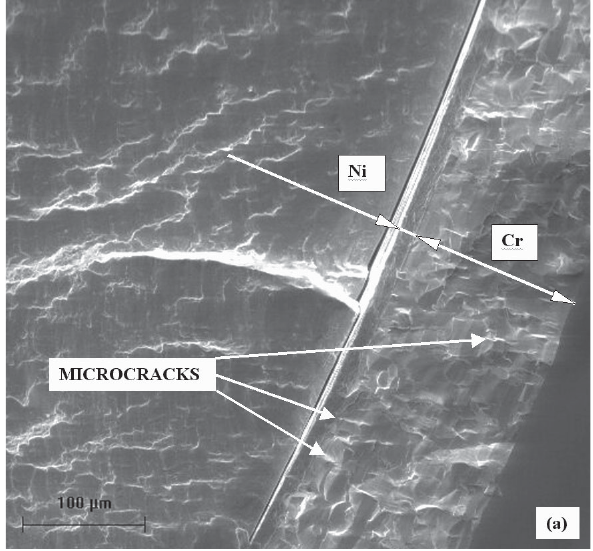
Figure 5a. Fracture surface of accelerated hard chromium (145 µ m) on electroless nickel (15 µ m) plating, unshot peened.